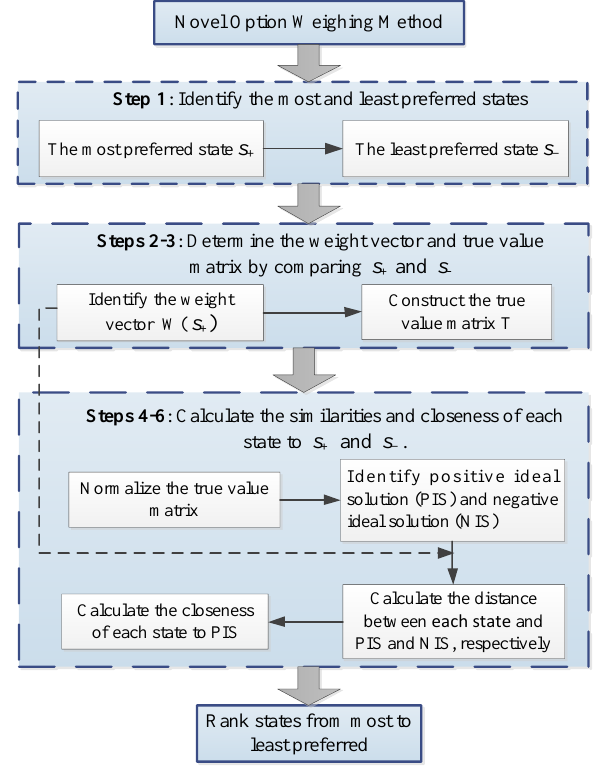
Figure 1. The procedure for preference ranking using the novel option weighing approach.